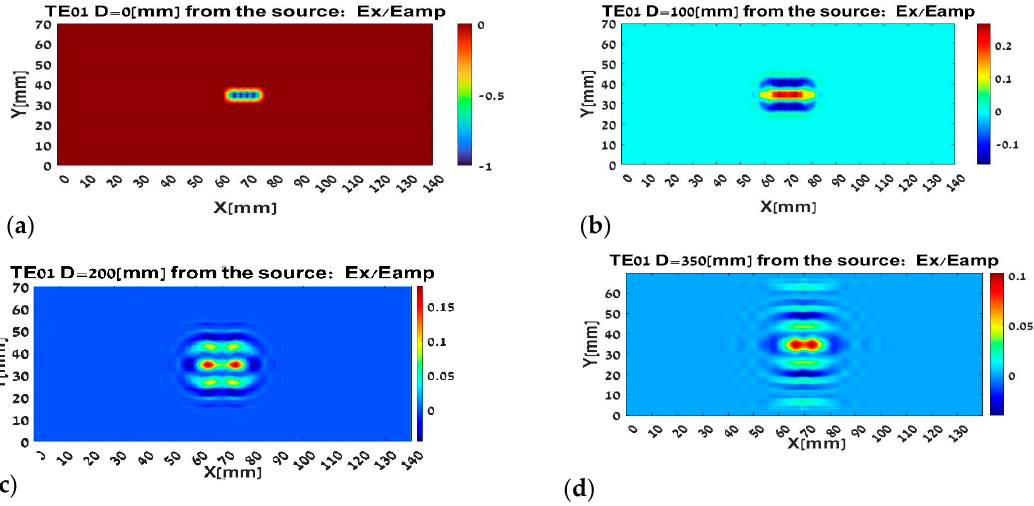
Figure 5. The TE 01 mode propagation in term of the rays: ( a ) at the out of the waveguide; ( b ) after passing 100 mm, ( c ) after passing 200 mm, and ( d ) after passing 350 mm.